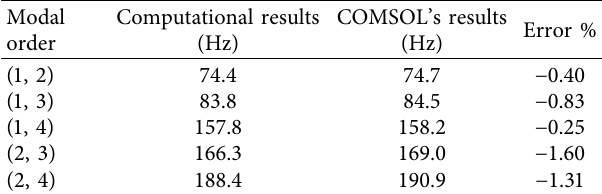
Table 2: Natural frequencies of double-sided water immersion bare cylindrical shell.